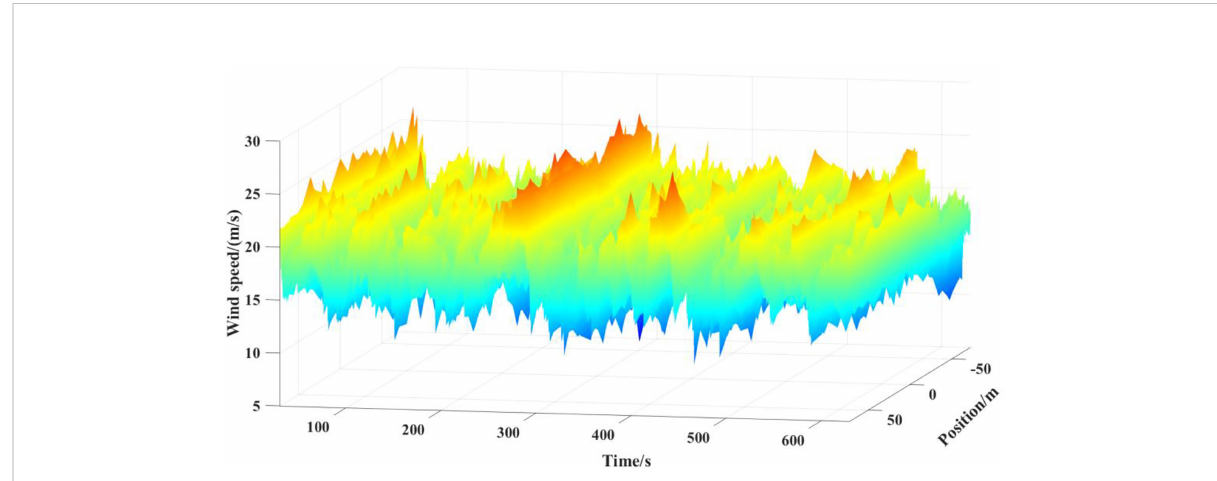
FIGURE 8 Synthesized three-dimensional turbulent wind fi eld with an average speed of 18 m/s at the hub